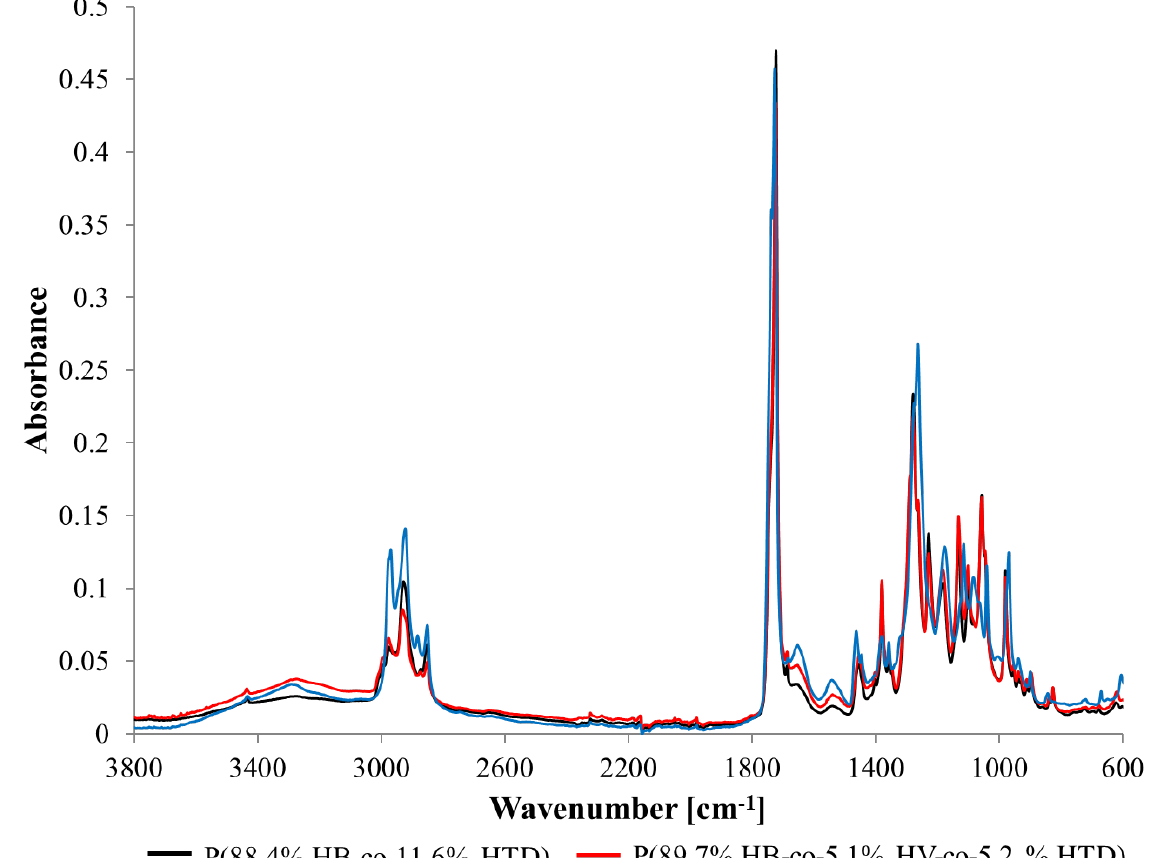
Figure 4. FTIR spectra of selected samples: ( black line ) P(88.4% HB-co-11.6% HTD) extracted from the culture supplemented with 10% SMCFAs synthetic -rich stream under nitrogen-limited condition ( red line ) P(89.7% HB-co-5.1% HV-co-5.2% HTD) extracted from the culture supplemented with 1 g/L of caproic acid under non-limited condition, ( blue line ) P(4.9% HB-co-84.0% HV-co-8.5% HtriD-co 2.6% HTD) extracted from the culture supplemented with 2 g/L of valeric acid under nitrogen-limited condition. Table 4. Functional group and its quantified frequencies of extracted PHAs.